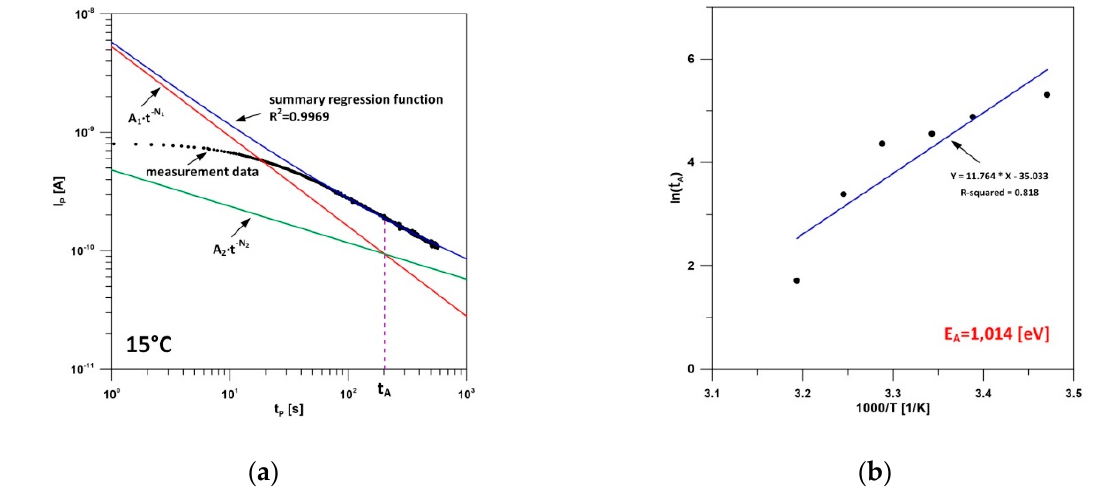
Figure 10. Method of fixing the activation energy E A for a selected non-aged cellulose–aramid insulation sample with the smallest degree of moisture: ( a ) way of fixing t A characteristic time from the polarization current; ( b ) Arrhenius graph.